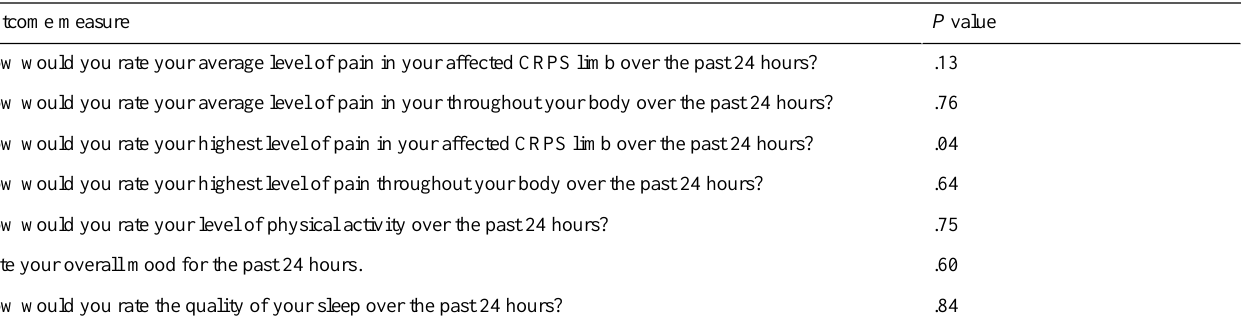
Table 2. Nonsignificant effects of time on patient self-reported outcomes using linear mixed models, predicting each outcome measure averaged at each time point and including participant ID as a random effect. Alpha adjusted to .007 using Bonferroni correction for multiple comparisons. We note that this study was not powered to detect